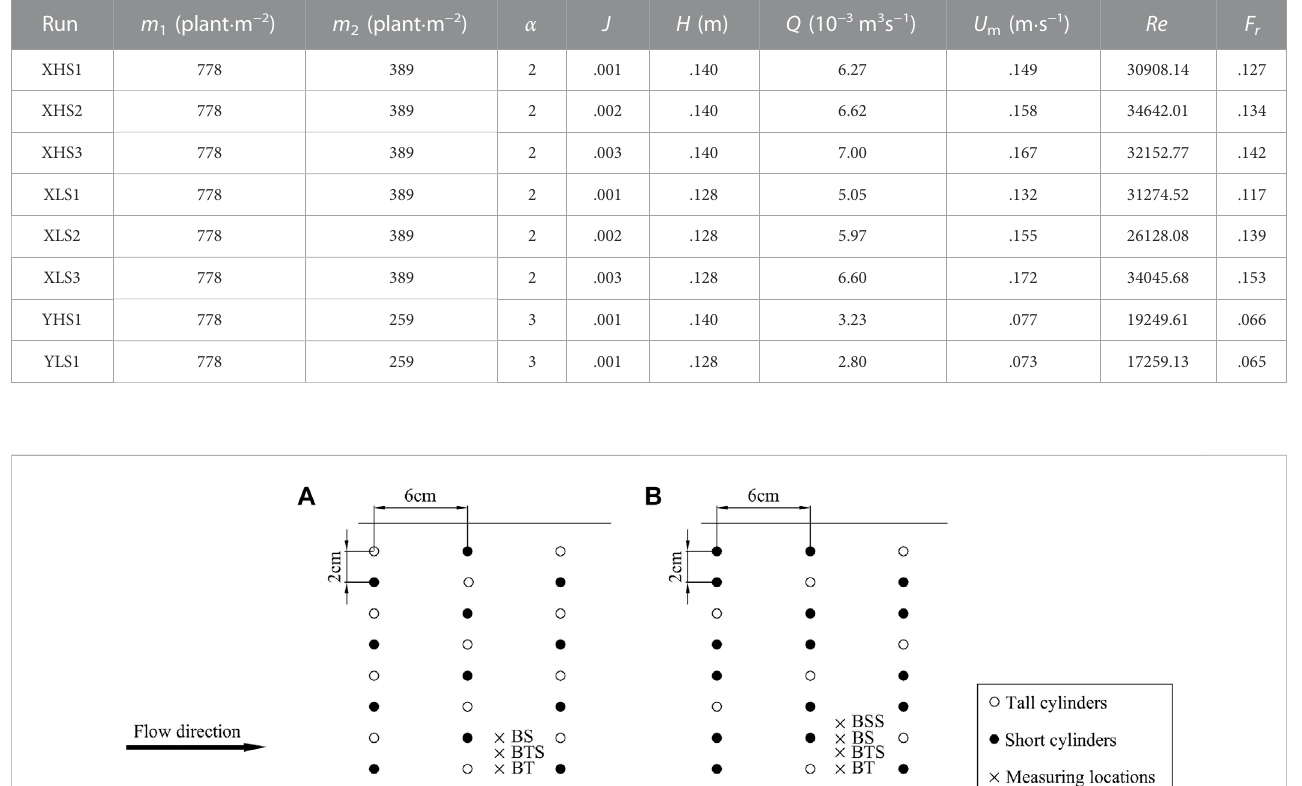
TABLE 1 Experimental parameters of each run. Run